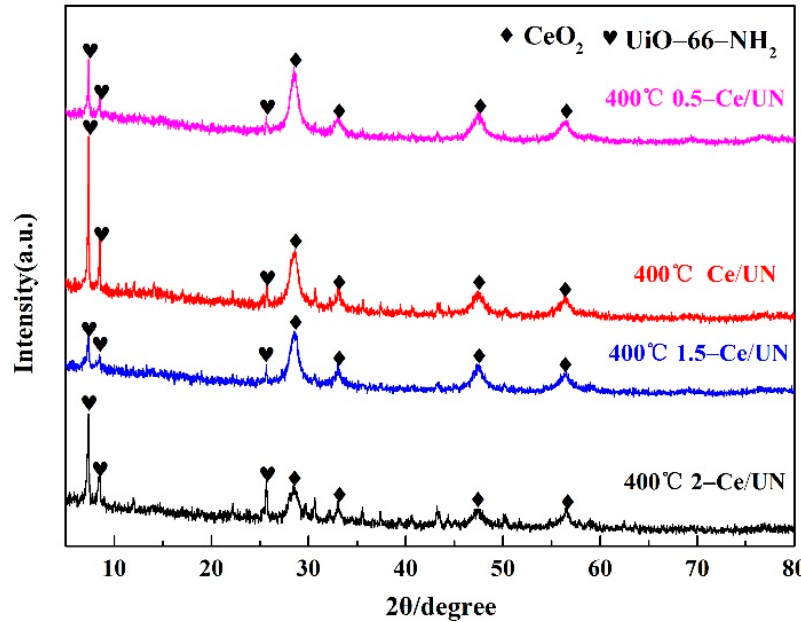
Figure 5. XRD patterns of 400 °C Ce/UN with different composite proportions.